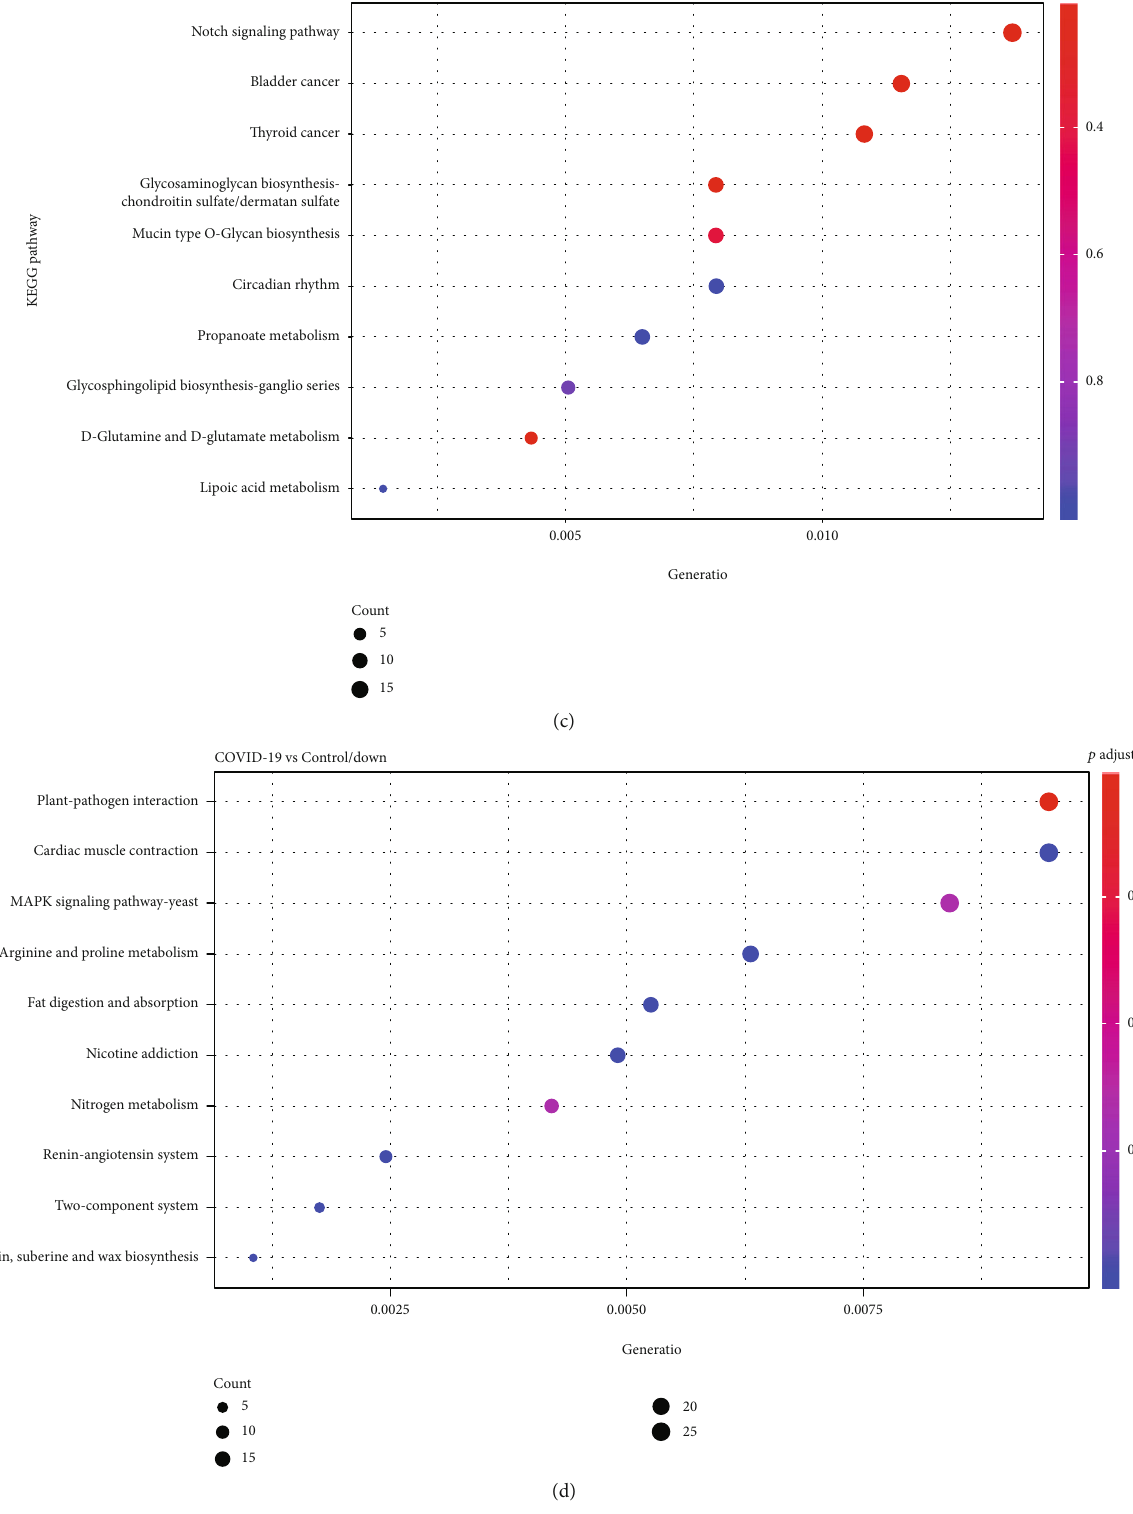
Figure 3: Go terms and KEGG pathway enrichment of up/downregulated DE mRNAs in peripheral blood samples of COVID-19 patients. GO term functional enrichment with 3 categories (BP, MF, CC) for upregulated DE mRNAs (a) and downregulated DE mRNAs (b). Top 10 pathways enriched by upregulated DE mRNAs (c) and downregulated DE mRNAs